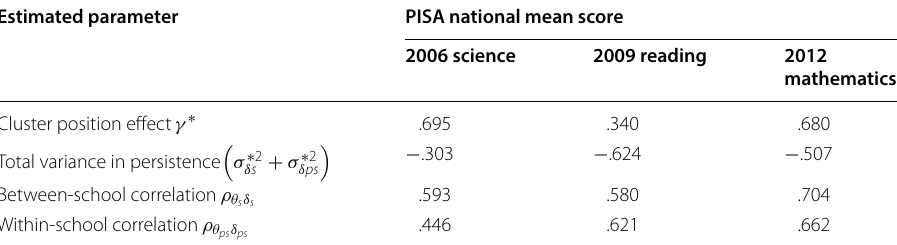
Note All correlations are significant at an alpha level of